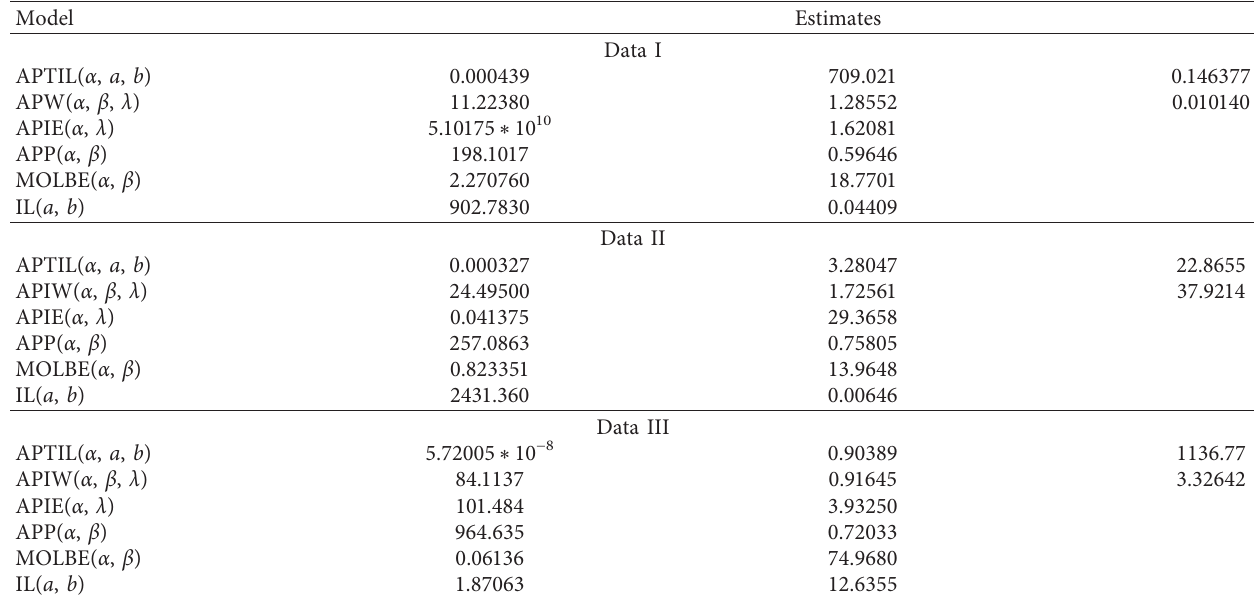
Table 6: Estimated values for the data